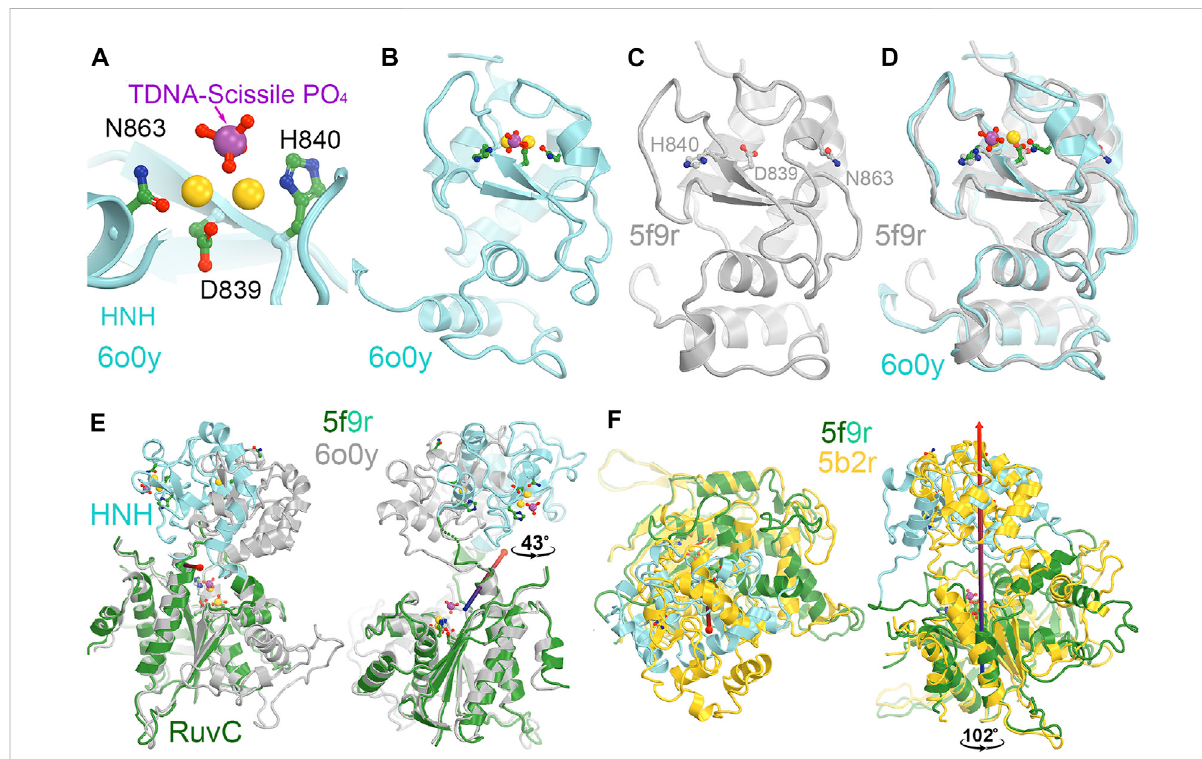
FIGURE 5 HNH catalytic site. (A) A close-up view of the HNH active site in the catalytically relevant complex of 6o0y with one Mg 2+ ion computationally modeled. (B) A zoomed-out overall view of the entire HNH domain of 6o0y. (C) An overall view of the inactive 5f9r HNH domain. Note that N863 points away from H840. (D) Superposition of the 6o0y and 5f9r HNH domains. (E) Two views of superpositions of the RuvC domain to see relative rotations of the HNH domain between the 5f9r and 6o0y complexes. Rotation axis is indicated by the arrow. (F) Two views of superpositions of the RuvC between the 5f9r and 5b2r